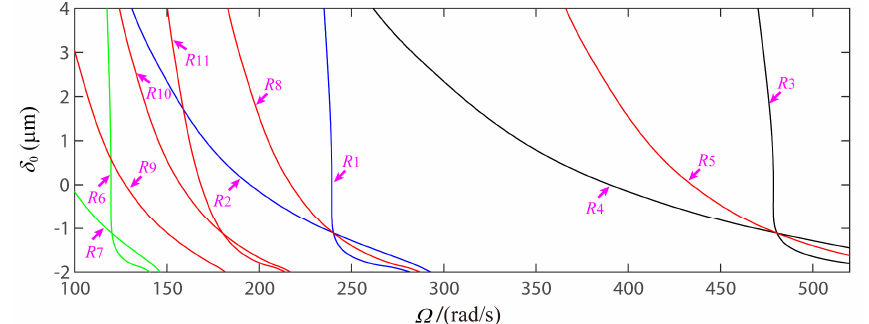
Figure 13. The locations of primary resonances (blue lines), 1/2-order subharmonic resonances (black lines), 2-order superharmonic resonances (green lines), and combination resonances (red lines) predicted by the equivalent resonant frequencies ω x 0 and ω y 0 .